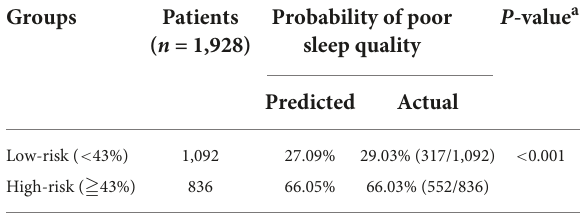
TABLE 4 Risk classification based on the nomogram and corresponding predicted and actual probability of poor sleep quality among the entire cohort of university